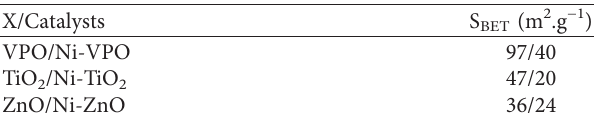
Table 1: Specific surface area of